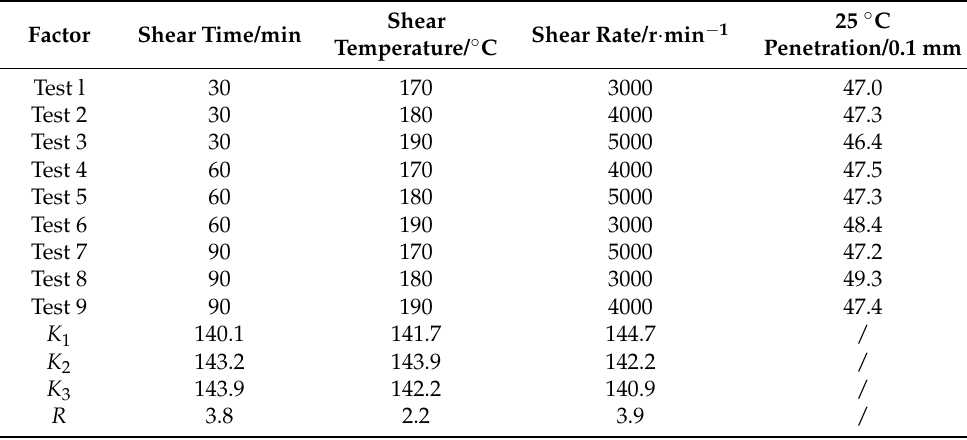
Table 7. Calculation results of penetration test R and K values of PE modified